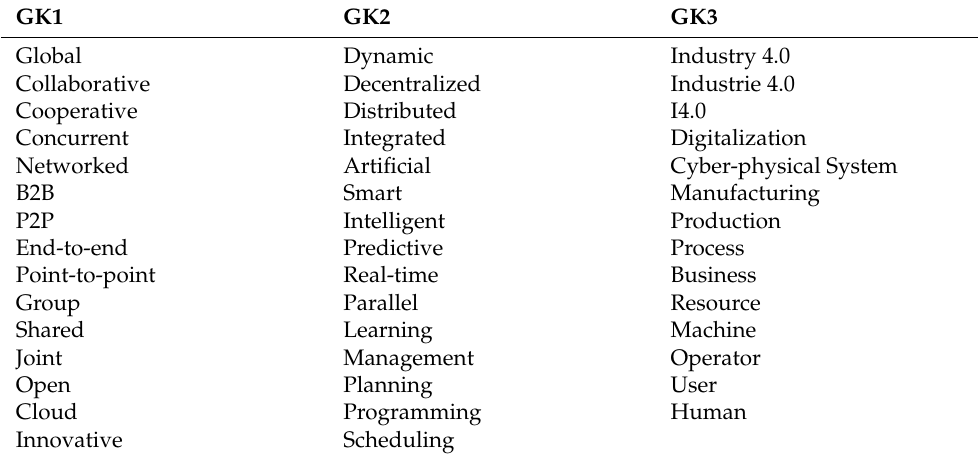
Table 1. Main groups of key words used in the search